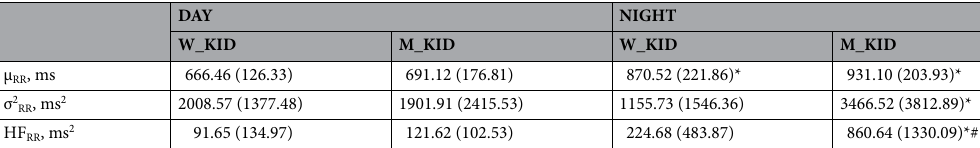
Table 4. Results of the cardiac autonomic profile comparison between W_KID and M_KID during DAY and NIGHT. DAY, daytime; NIGHT, nighttime; W_KID, women with children in preschool age; M_KID, men with children in preschool age; RR, RR interval; μ RR , mean RR; σ 2 RR , variance of RR; HF, high frequency; HF RR , power of RR series in the HF band. Results are presented as median. In bracket the interquartile range, calculated as the difference between the first and the third quartile is presented. * indicates p < 0.05 DAY versus NIGHT; # indicates p < 0.05 M_KID versus W_KID.